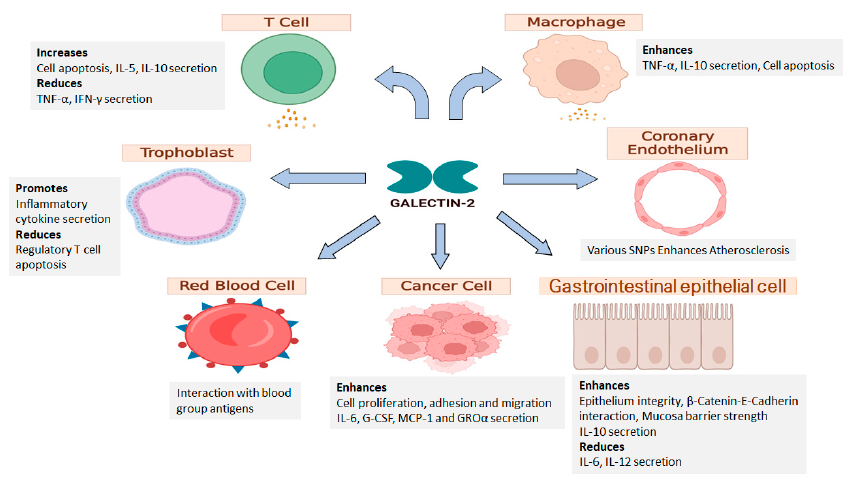
Figure 3. Possible effects of galectin-2 on activity of different cell types. Studies using mouse gastric epithelial cells have suggested the involvement of galectin-2 in protection of epithelial integrity of the GI tract. Several studies have also reported a role of galectin-2 in promoting immune cell apoptosis and induction of cytokine secretion by T cells, macrophages, trophoblasts and cancer cells. Galectin-2 was shown to recognize the blood group-associated glycans and to contribute to erythrocyte agglutination. Multiple galectin-2 SNPs are observed in cardiovascular and have been proposed to regulate tissue inflammation. Reduction of galectin-2 expression by trophoblasts has shown to be associated with pregnancy-associated disorders.